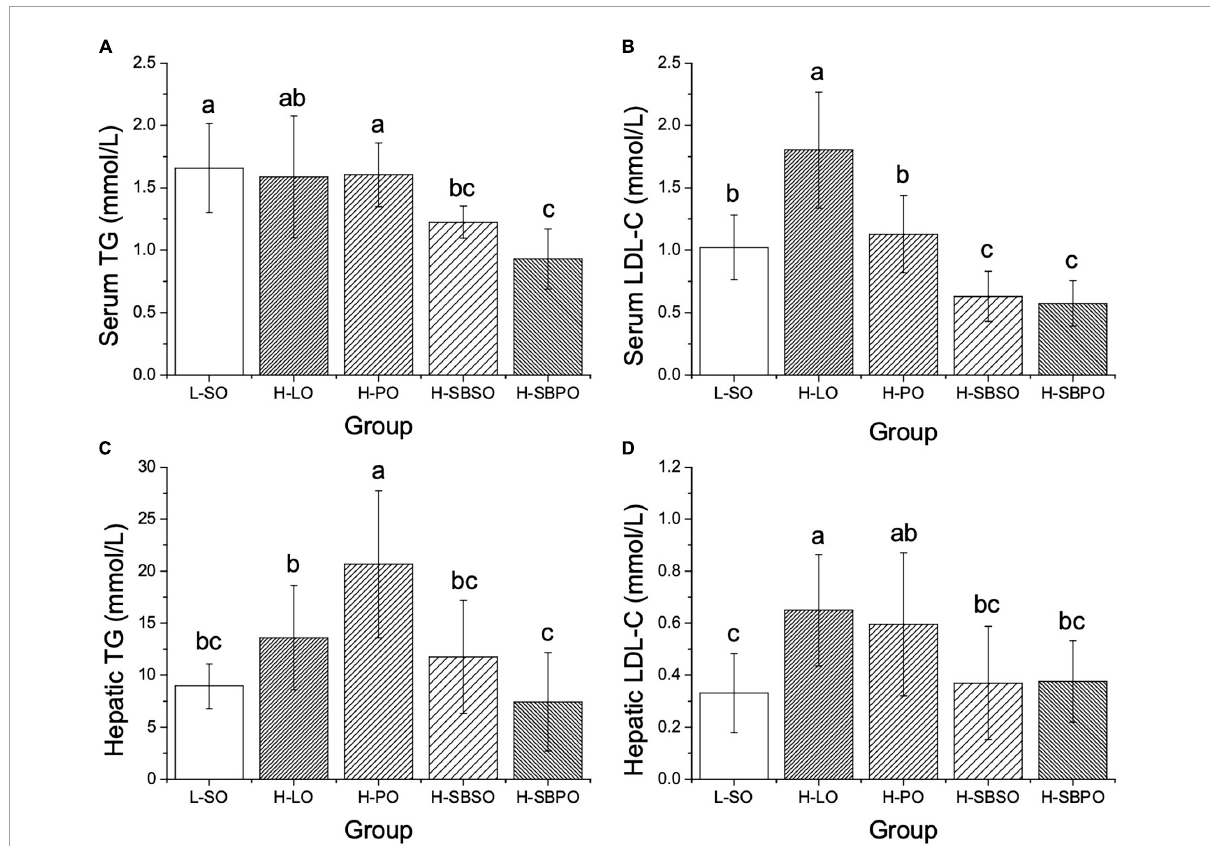
FIGURE2 Comparisons of (A) serum TG, (B) serum LDL-C, (C) hepatic TG, and (D) hepatic LDL-C of mice after 12 weeks fed with one of the five diets ( n = 10–12). L-SO, low-fat diet with soybean oil; H-LO, high-fat diet with lard oil; H-PO, high-fat diet with peanut oil; H-SBSO, high-fat diet with sea buckthorn seed oil; H-SBPO, high-fat diet with sea buckthorn pulp oil. Different letters (a, b, and c) indicate significant differences ( P < 0.05) of mice serum and hepatic TG and LDL-C between each